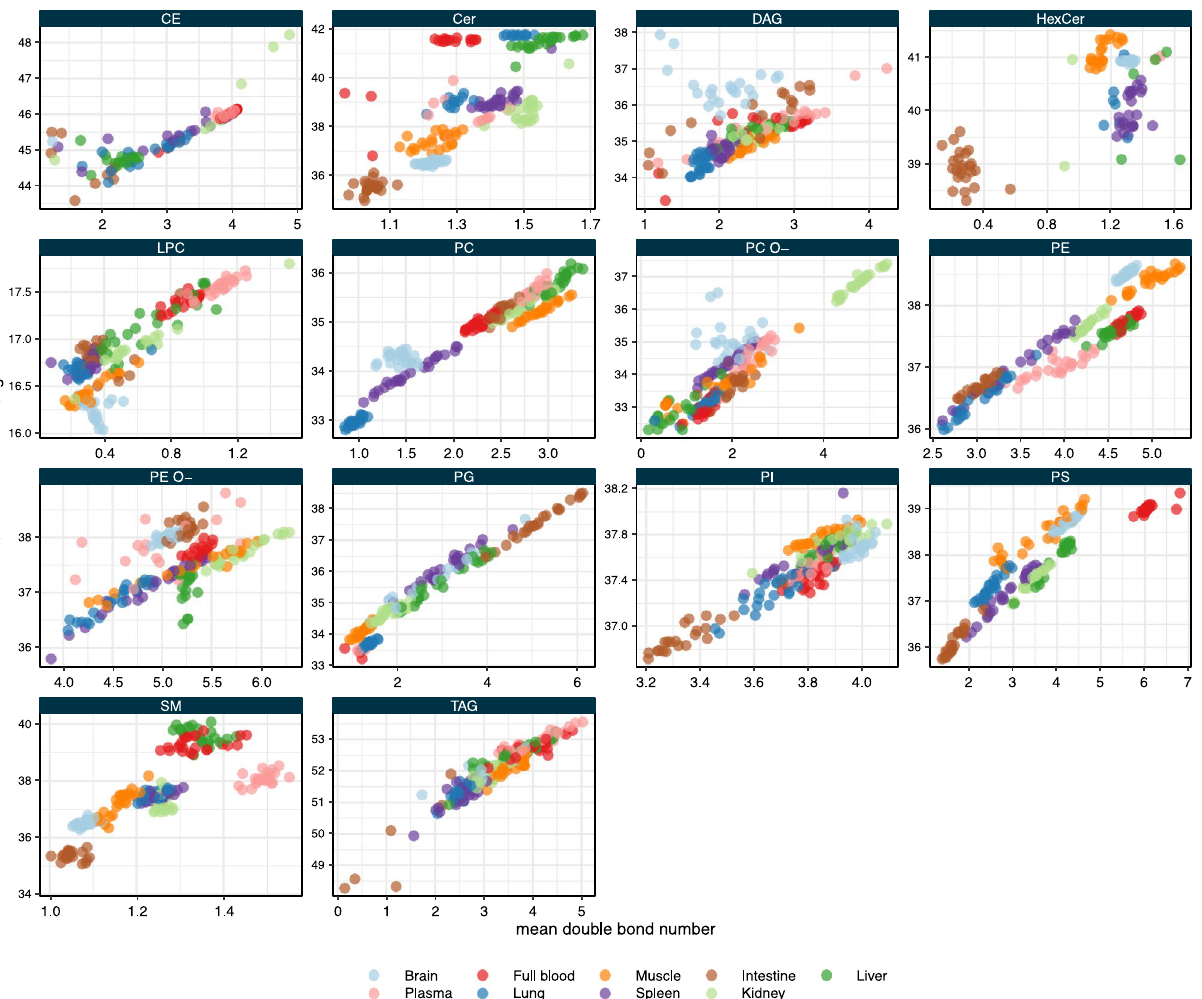
Figure 2. Feature profiles of the major lipid classes. Shown is the weighted mean number of double bonds per lipid class in a given sample and the weighted mean number of carbons in the hydrocarbon chain moiety per lipid class in a given sample (each dot represents an individual sample). Minor lipid classes (lyso-lipids) are omitted for